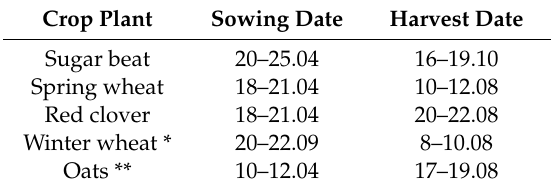
Table 4. Sowing and harvest dates of the crop plants included in the